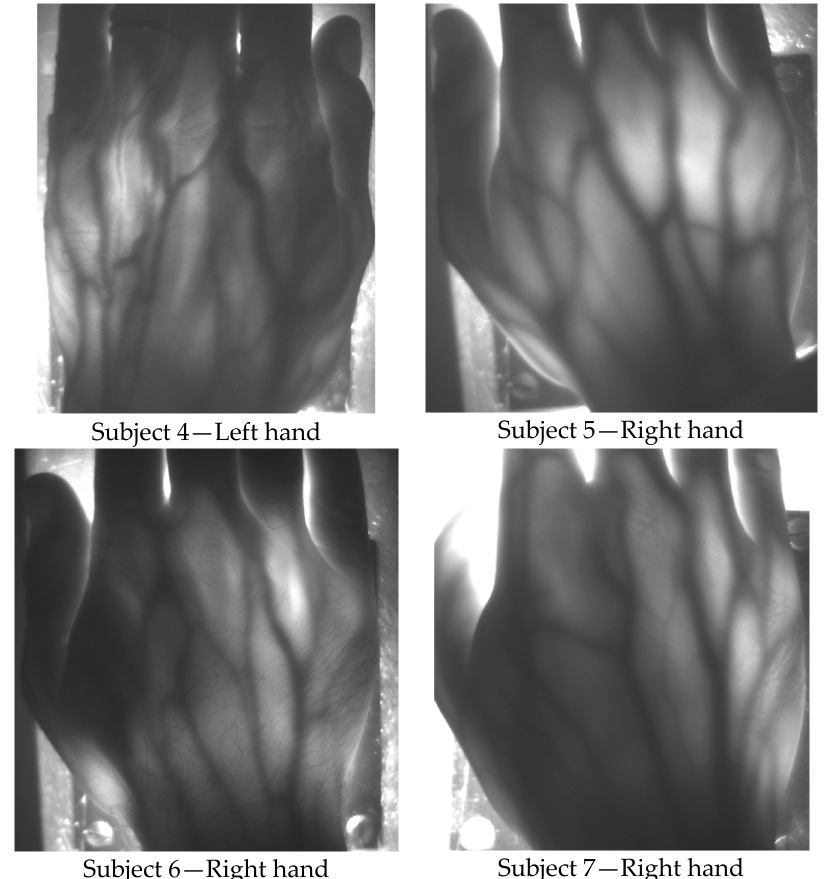
Figure 5. Raw pictures acquired with the transillumination system on white-skin, male subjects 4, 5, 6 and 7: morphological details are well visible in all subjects.